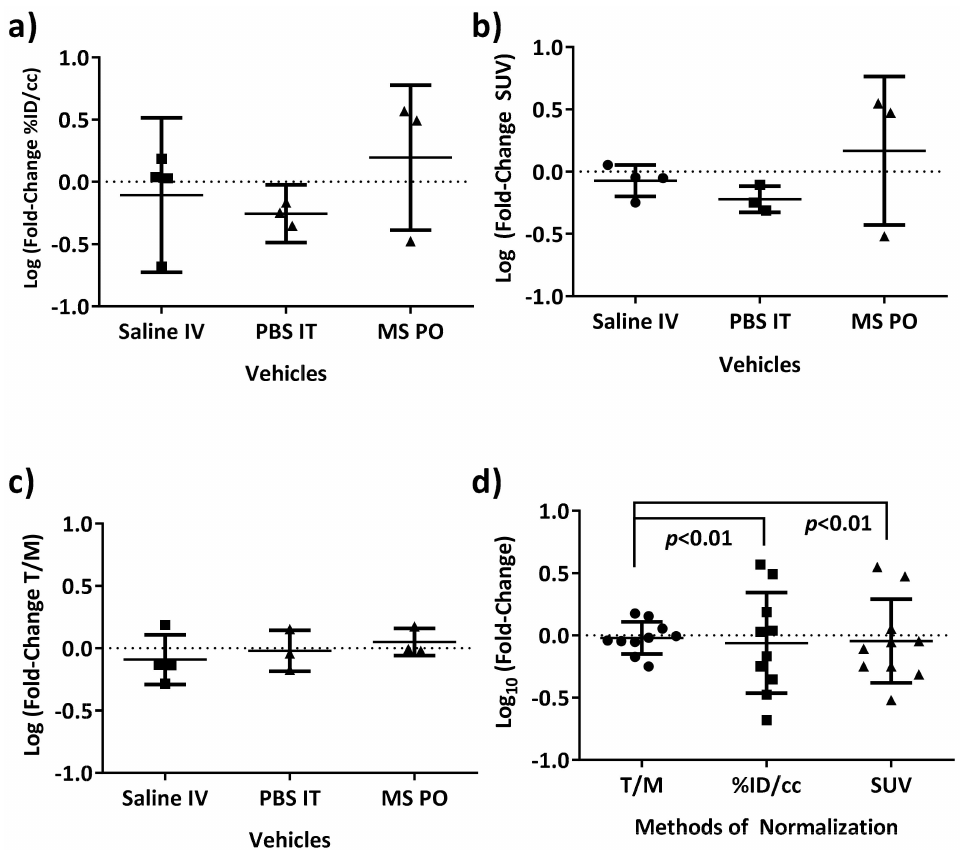
Figure 3. The log fold-change of [ 18 F]FAZA PET T / M ratios yield well-centered and precise measurements for vehicle treatments of SK-MEL-5 tumor bearing mice. To establish precision for baseline analysis of data, vehicle treatments by various routes (i.v., i.t., p.o.) in SK-MEL-5 tumor-bearing mice across the study were examined in detail. A metric that was well centered at 0 value (null